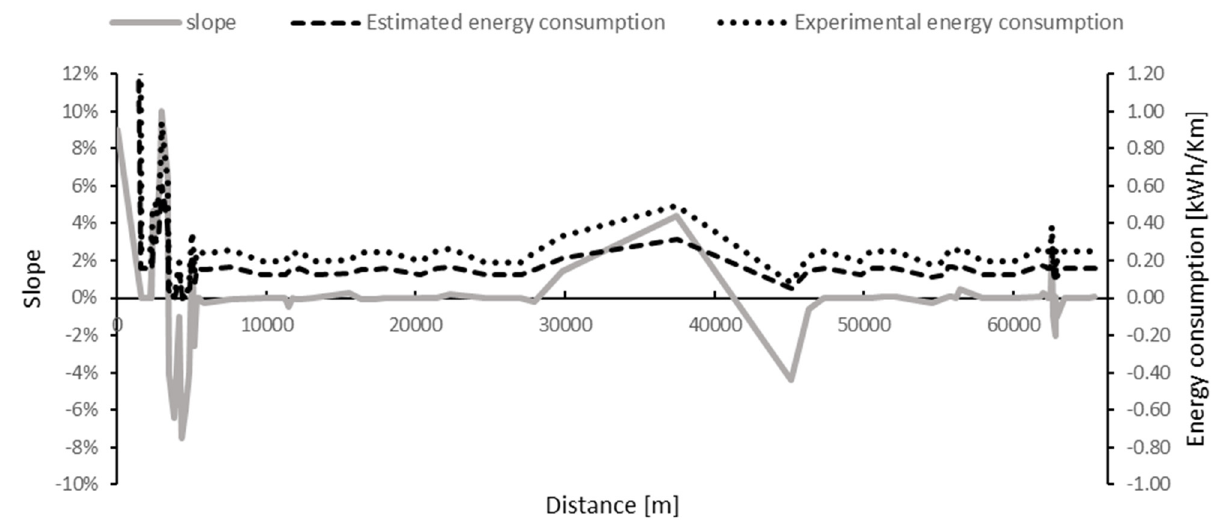
Figure 10. Comparison of disaggregated estimation of energy consumption (with literature parameters) and of estimation of energy consumption (with calibrated parameters of model 1).